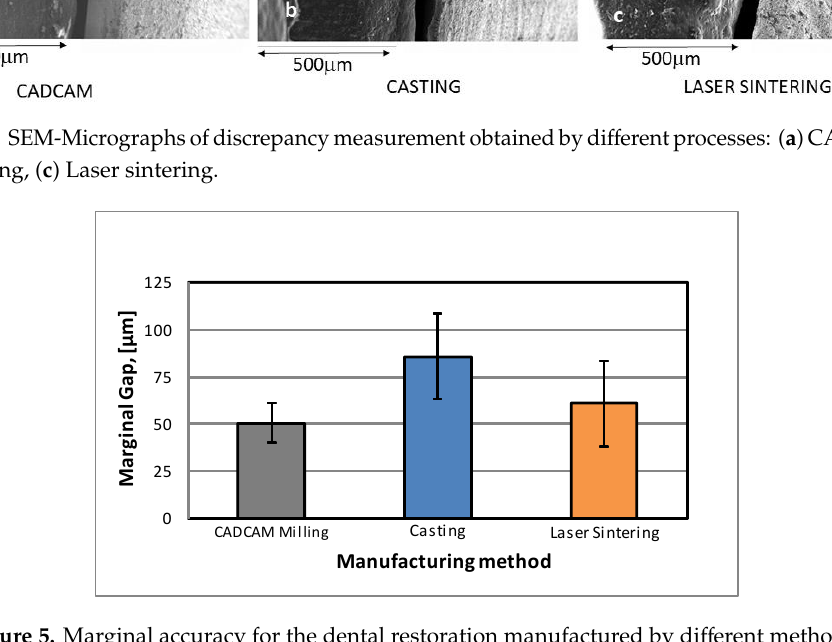
Figure 5. Marginal accuracy for the dental restoration manufactured by different methods. Table 2. Marginal gap, roughness, hardness and mechanical properties test